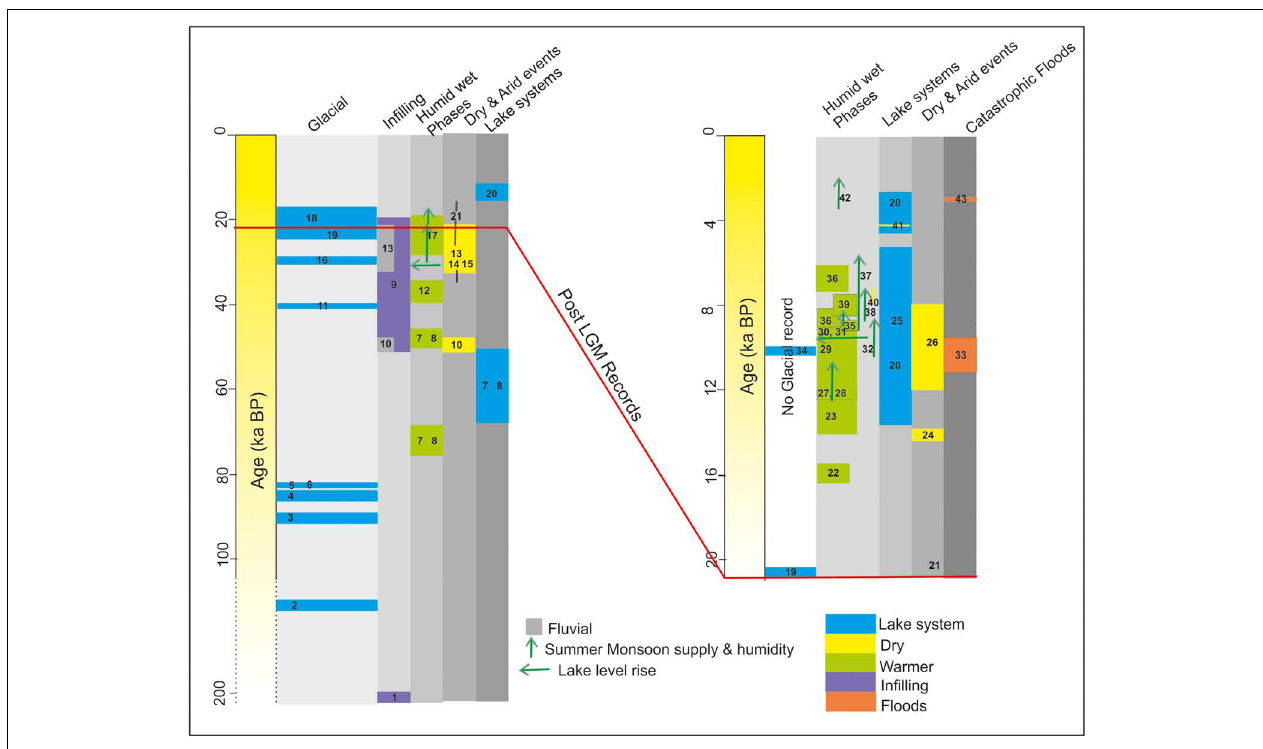
FIGURE 3 | Summary diagram showing different climatic regimes based on Table 1 in chronological order. The numbers shown in the diagram are taken from Table 1 as reference numbers to show the study referred, and the proxy used to infer the climatic regime as well as the dating technique applied by the respective authors. The vertical and horizontal arrows are used to show an increase in monsoon supply and lake level rise, respectively. The length of the different color boxes is indicative of the time duration to which the climate was in a particular mode,